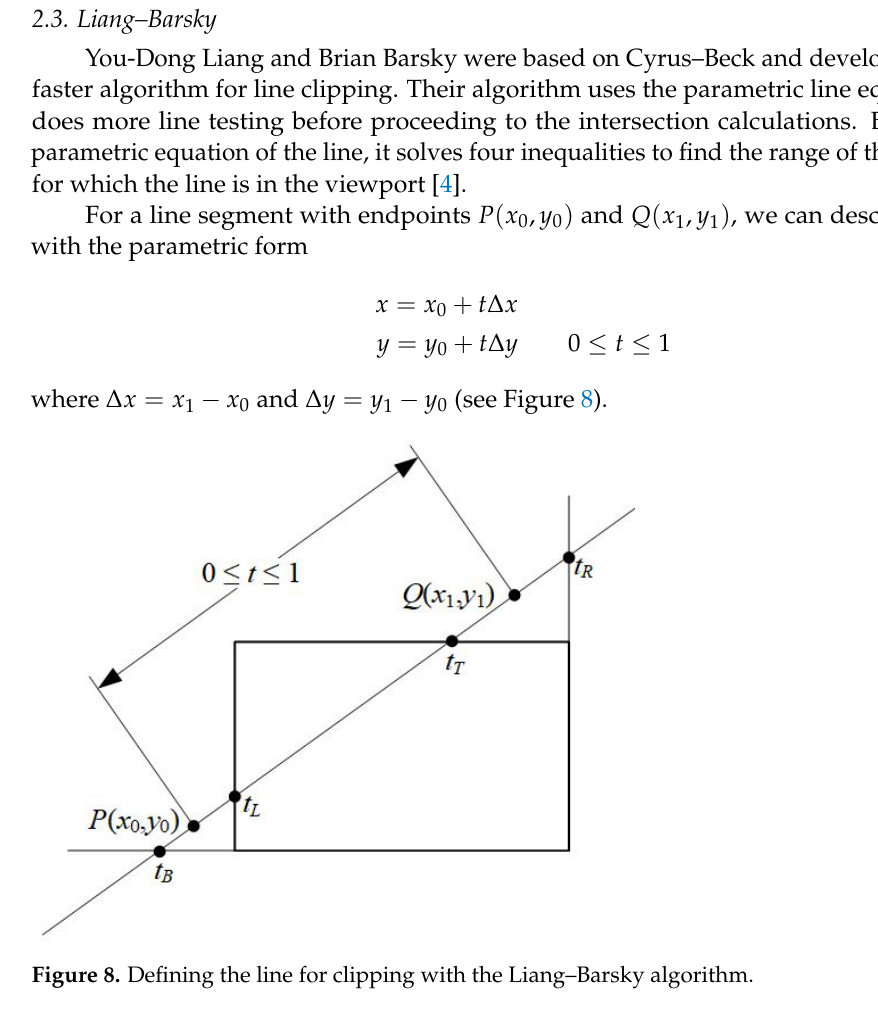
Figure 7. Comparing each inward normal with vector